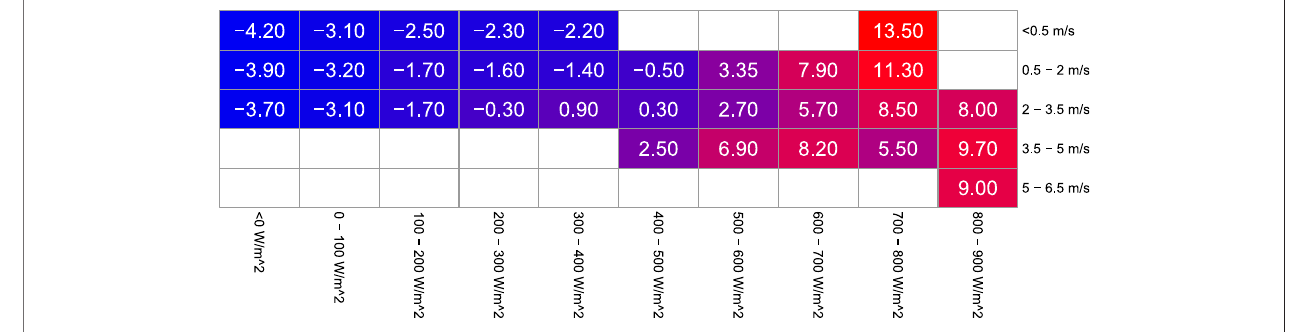
FIGURE 6 | Radiation bias of smartphone temperature readings T s as a function of wind speed and global radiation.